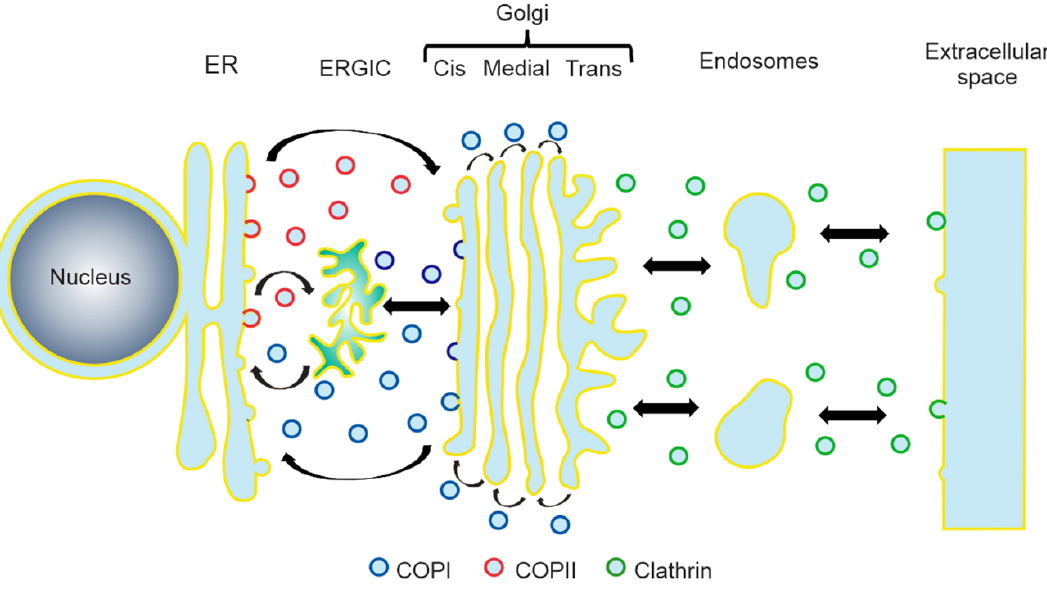
Figure 1. Schematic diagram of the roles of COPI, COPII, and clathrin in the vesicular secretory pathway. ER, endoplasmic reticulum; ERGIC, ER-Golgi intermediate compartment.